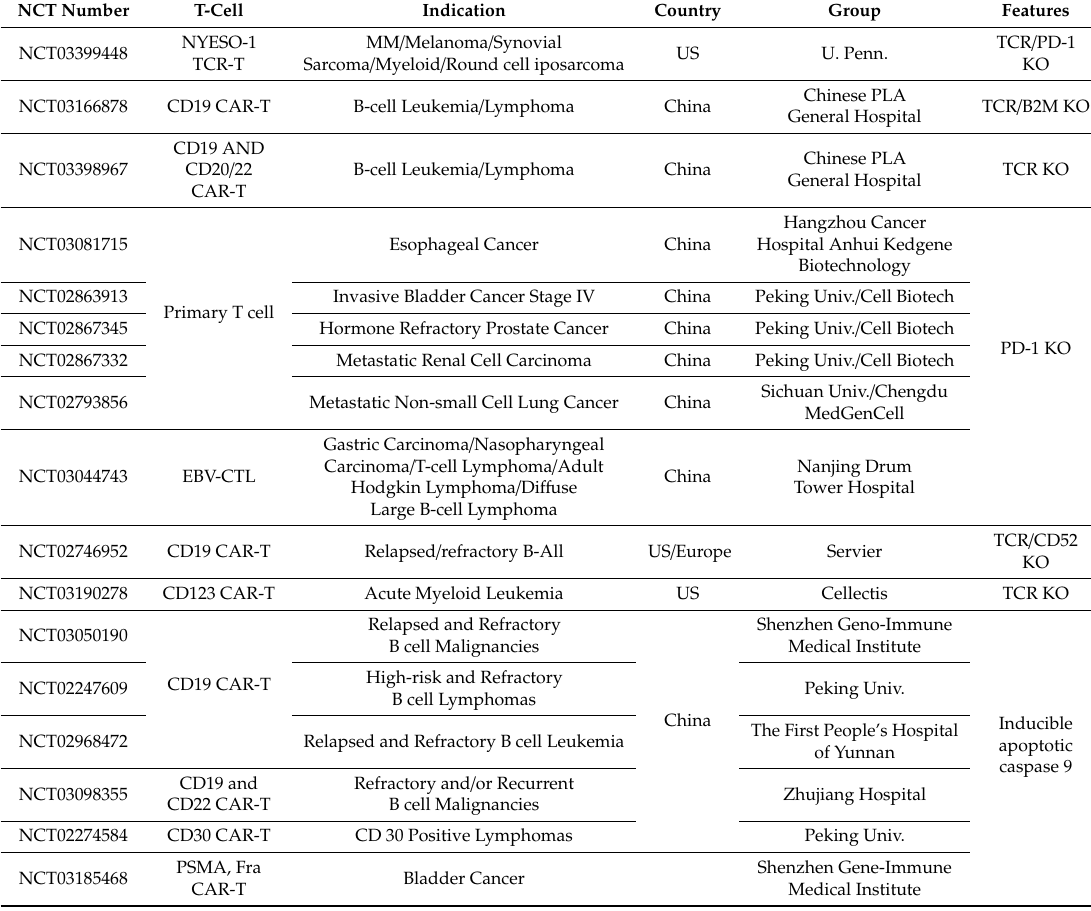
Table 1. Clinical trials of gene edited- or fourth generation CAR-T cell